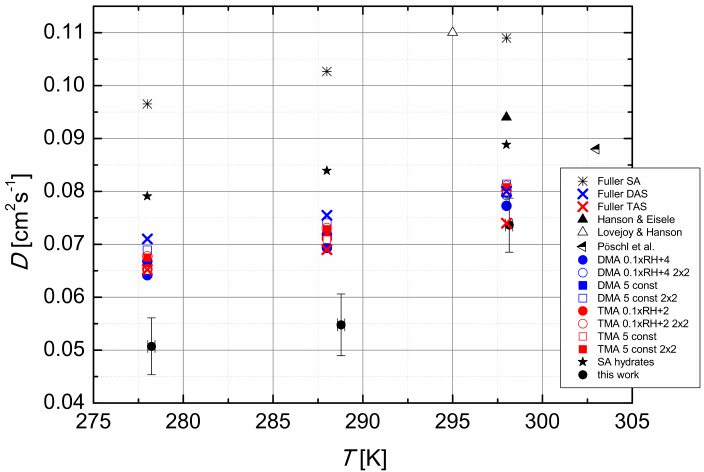
Figure 5. The temperature dependence of the effective H 2 SO 4 diffusion coefficient, calculated using the Fuller method for dry H 2 SO 4 (SA), dimethylamine-(DAS) and trimethylamine-sulfate (TAS), both in dry air, data from literature, several assemblies of cluster population simulations (see text for details) and data measured experimentally in this work. The temperature dependence of the experimental diffusion coefficients was found to be a power of 5.6.